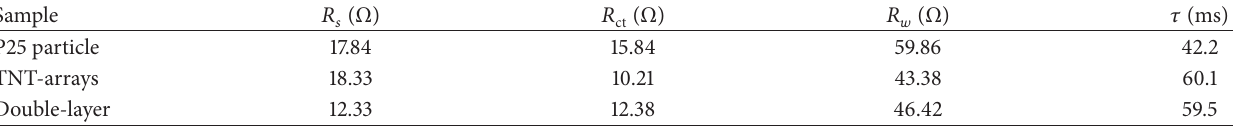
Table 2: Parameters obtained by fitting the impedance spectra of DSSCs using the equivalent circuit in Figure